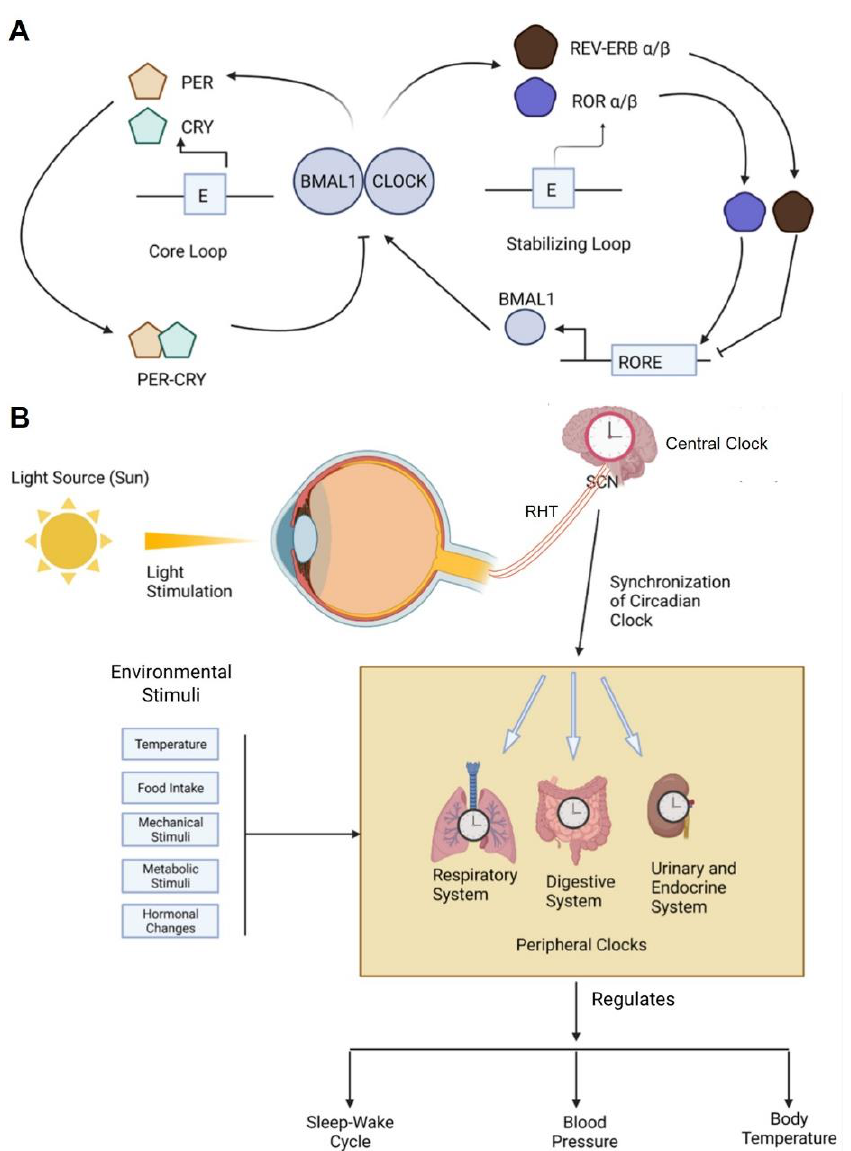
Figure 1. The core circadian timing systems in mammals. ( A ) Schematic of the molecular mechanisms of the circadian clock oscillator. At the molecular level, the circadian loop consists of a core loop and a stabilizing loop. In the core loop, the heterodimer BMAL1/CLOCK binds to the E box enhancer